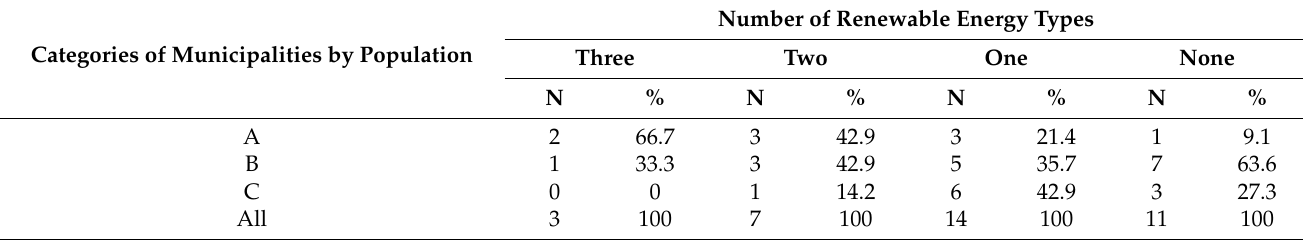
Table 2. Number of types of renewable energy deployed by different types of Cittaslow municipalities.